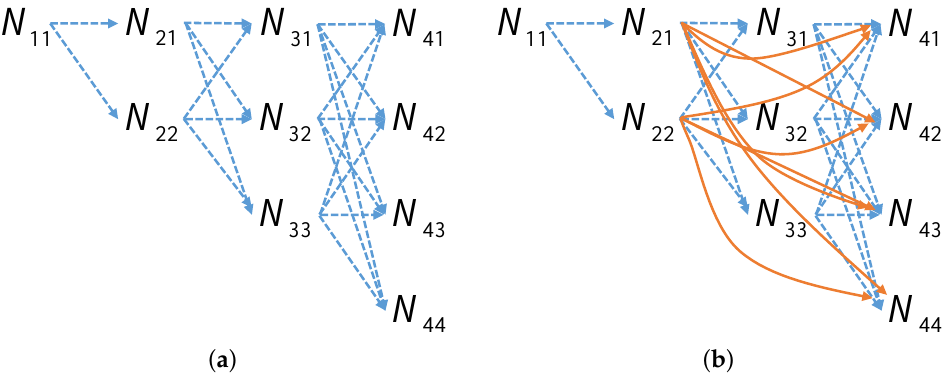
Figure 3. Simplified architectures of HRNet and the densely connected HRNet. The blue dotted line in the figure corresponds to the connecting line of the original HRNet. The solid red line in the figure represents the proposed short-circuit connection line to connect the initial high-resolution convolutional feature maps to the later low-resolution convolutional feature maps. ( a ) HRNet. ( b ) Densely Connected